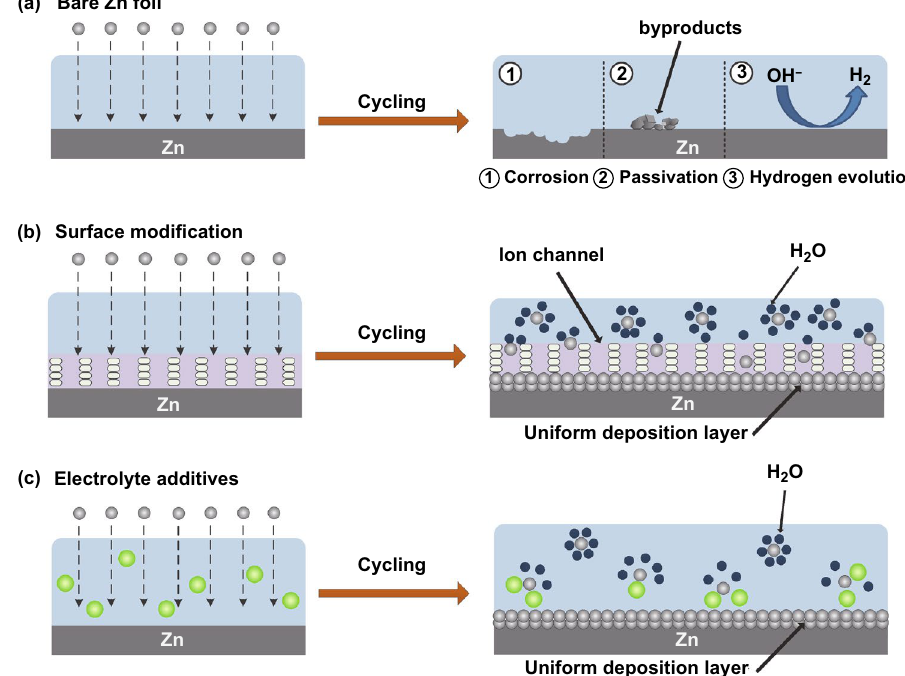
Fig. 3 a Schematic diagram of the corrosion, passivation, and hydrogen evolution reactions on bare Zn. b Schematic diagram of the morpho- logical evolution of coated Zn. c Schematic diagram of the deposition morphology of Zn ions by adding electrolyte